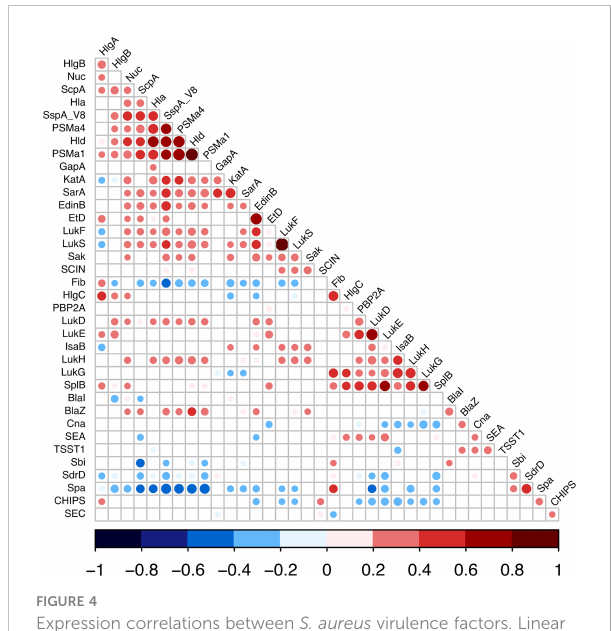
FIGURE 4 Expression correlations between S. aureus virulence factors. Linear correlations between the expressions of 37 virulence factors were tested using Pearson correlation test. Non-signi fi cant correlations are represented as empty squares and signi fi cant correlations as dots. The dot size is negatively proportional to the p-value. The Pearson coef fi cient values are represented as dark blue for negative values to dark red for positive ones.